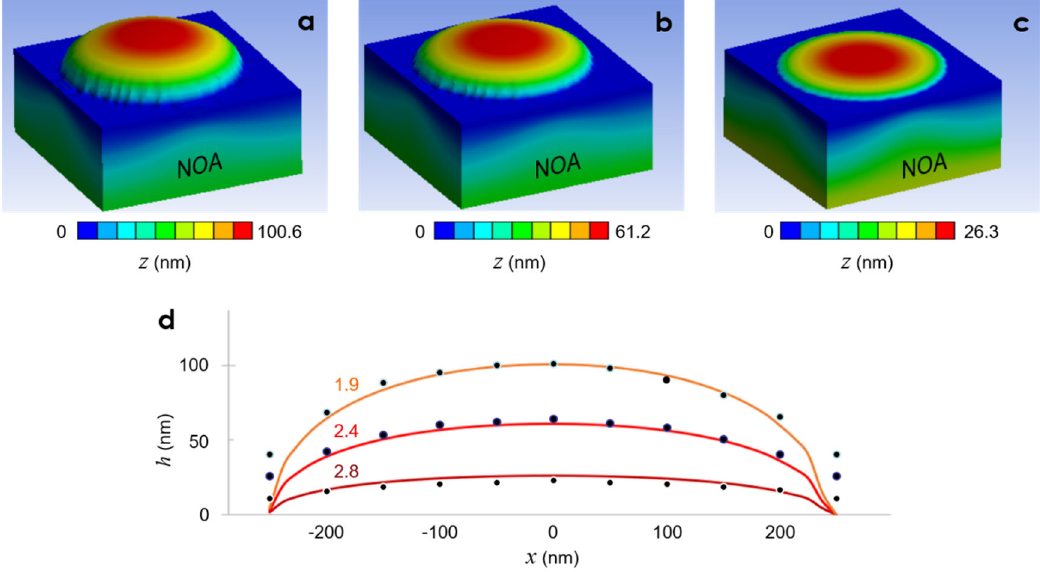
Figure 5. Best ‐ fitting simulation results: ( a – c ) bird’s eye view plots of deformed shapes of the three different UV doses in Table 1 (1.9 J/cm 2 , 2.4 J/cm 2 , and 2.8 J/cm 2 ), respectively. ( d ) Simulated cross ‐ sectional profiles of the nanolenses corresponding to the three different UV dose levels (specified by the text labels). The dark dots represent the experimental results shown in Figure 4f.